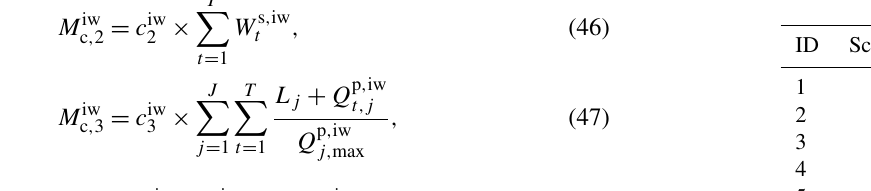
Table 2. Five input combination